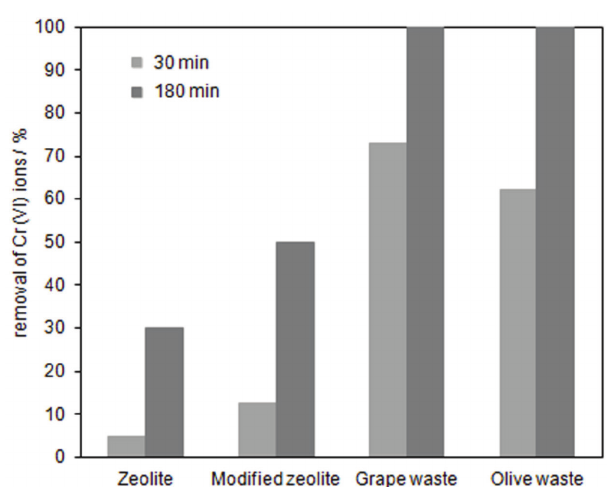
Fig. 1 – Percentage of removal of Cr(VI) ions by natural zeolite, modified zeolite, grape and olive wastes (γ